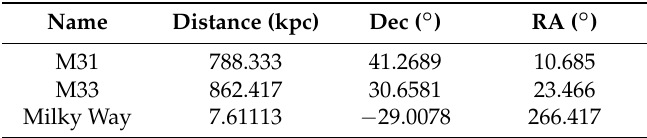
Table 6. Coordinates of the Local Group spiral galaxies.